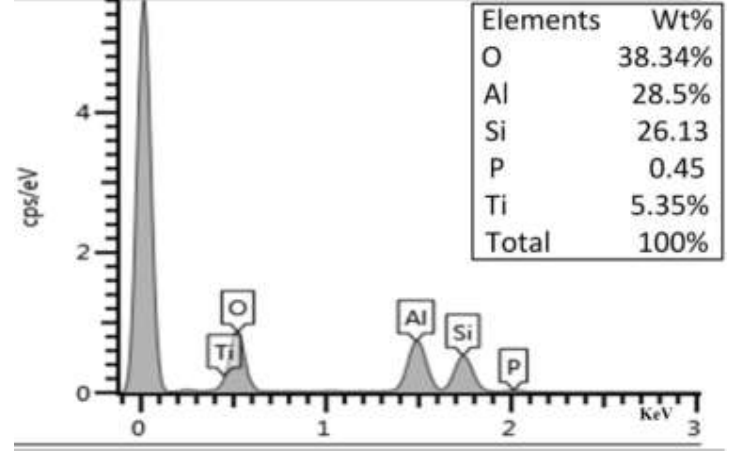
Figure 4: EDX spectrum of AAO template on Ti/Si